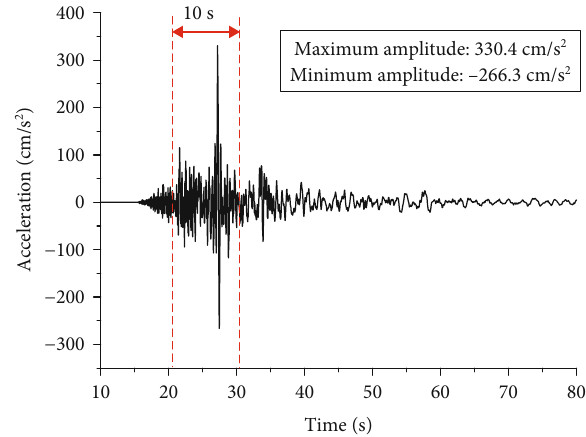
Figure 6: Input motion adopted in the numerical simulations.